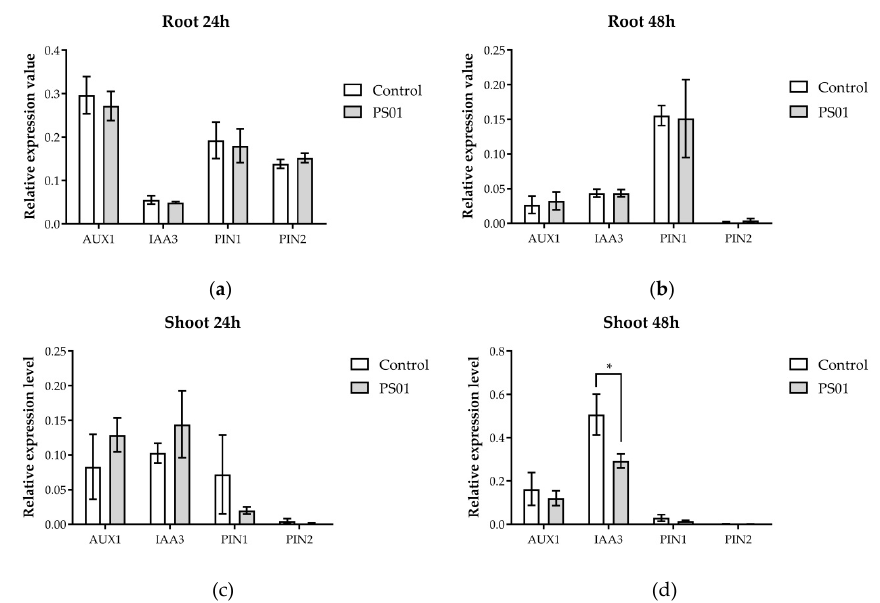
Figure 8. Effect of inoculation with PS01 on the expression levels of genes involved in auxin transport and transduction in Arabidopsis ( AUX1, IAA3 , PIN1 , PIN2 ) (Table S1). RT-qPCR analyses of gene expression have been performed separately on root ( a, b ) and shoot ( c, d ) at 24 and 48 h after inoculation, as indicated. The bars presented are the mean expression levels ± SD ( n = 3). Gene expression was normalized to Actin (At3 g18780) expression level . Asterisks indicate significant differences (Student’s t test; p < 0.05).